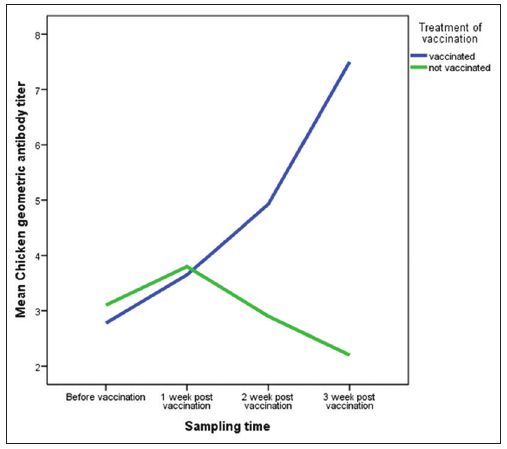
Figure-2: The increased titer of egg drop syndrome antibody in laying hens before and after